Question: Provide a one-line summary of what is displayed.
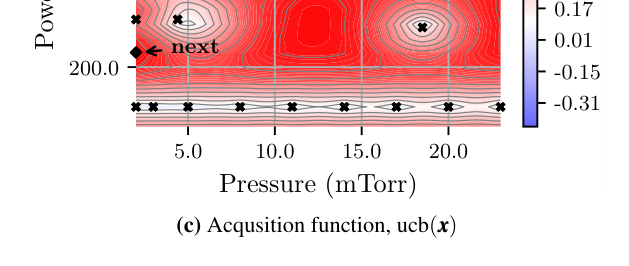
Answer: The figure shows the contour plots of exploitation term, µpos in Fig. 7a, exploration term β ·σpos in Fig. 7b, and UCB in Fig. 7c for the tenth iteration with β = 1. At this iteration, BayesOpt is exploring the region X2.